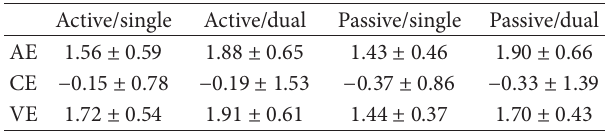
Figure 3: Mean ± SD constant errors for each condition in experiment 1 a. AS: active/single task, AD: active/dual task, PS: passive/single task, PD: passive/dual task. Table 3: Average joint position-matching errors in experiment 1b (mean ± standard deviation).